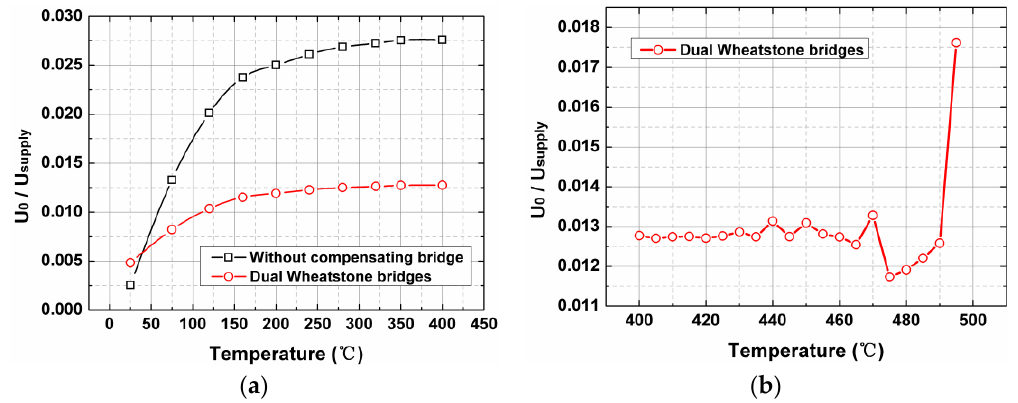
Figure 4. ( a ) Normalized residual temperature drift of the high-temperature MEMS surface fence. ( b ) The abnormal sensor outputs at higher